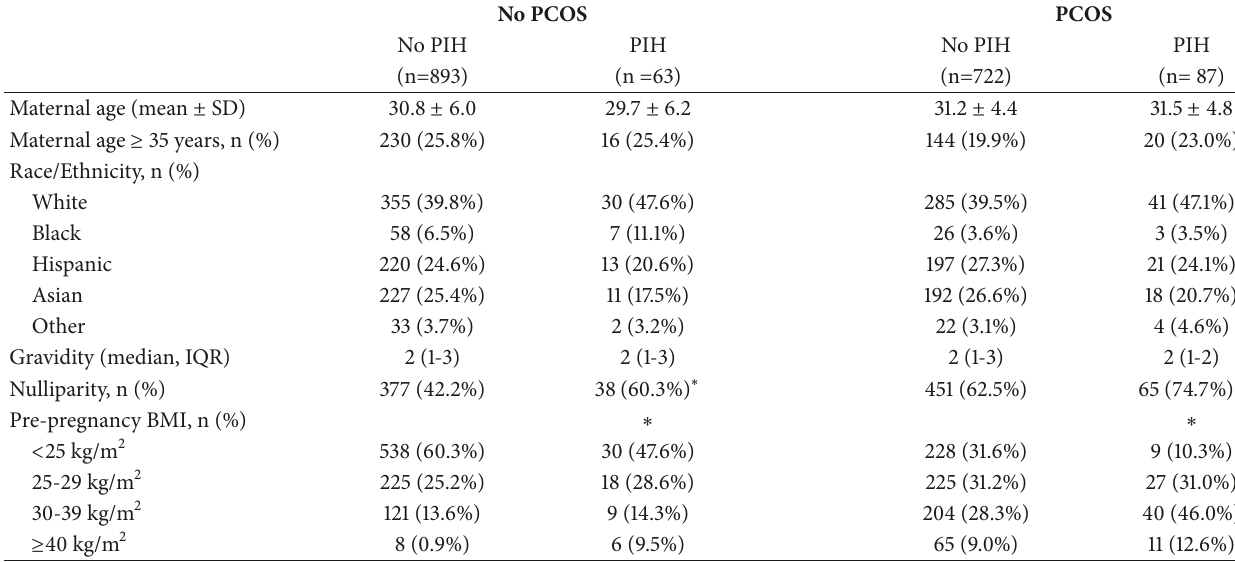
Table 2: Clinical characteristics of women without preexisting hypertension by polycystic ovary syndrome (PCOS) and pregnancy-induced hypertension (PIH)